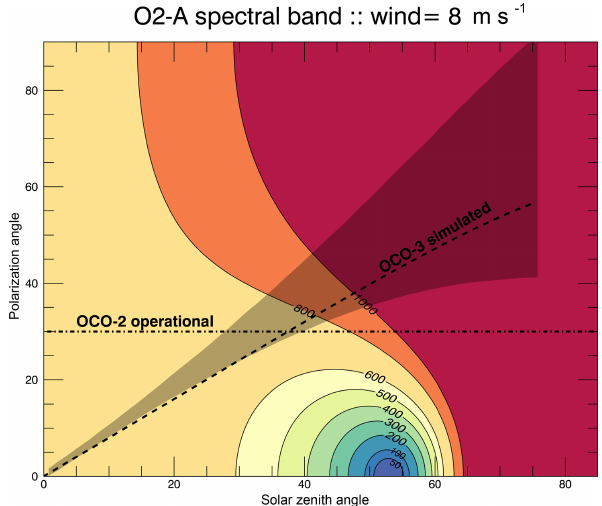
Figure 6. Contour plot of the theoretical SNR versus solar zenith and polarization angles as determined from a Cox and Munk sur- face reflectance model. Results here are for the O 2 A band assuming an 8ms − 1 surface wind speed. Results for the CO 2 spectral bands and for other realistic wind speeds look qualitatively similar (not shown). The fixed OCO-2 operational polarization angle due to the 30 ◦ instrument yaw is indicated by the horizontal dot-dashed line, while the simple relationship between the OCO-3 polarization an- gle and solar zenith angle used in these simulations is indicated by the dashed line. The gray shaded region shows the range of the ex- pected on-orbit OCO-3 polarization angles determined from recent